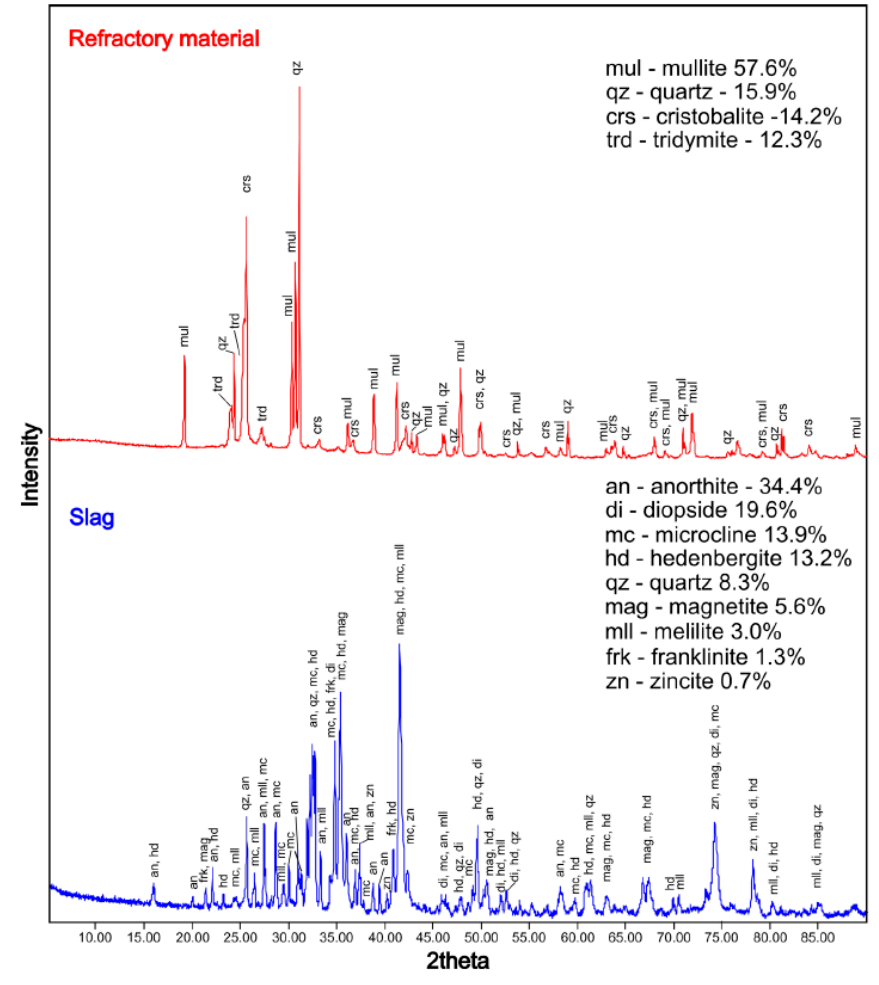
Figure 3. Diffraction pattern of slags and refractory material from Ruda Ś l ą ska. Figure 3. Di ff raction pattern of slags and refractory material from Ruda ´Sl